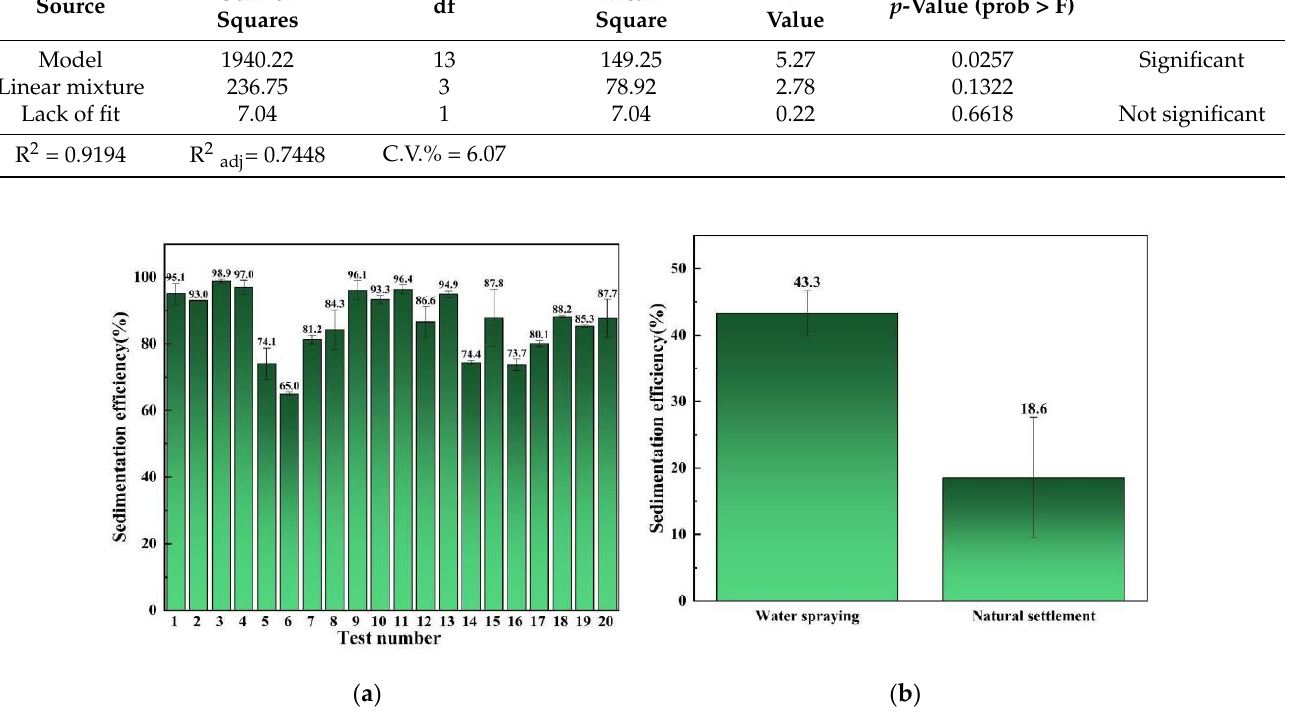
Figure 2. Aerosol settling efficiency: ( a ) the settlement of cesium aerosol by compound aerosol suppressants; ( b ) the settlement of cesium aerosol by water and natural settlement of cesium aerosol.